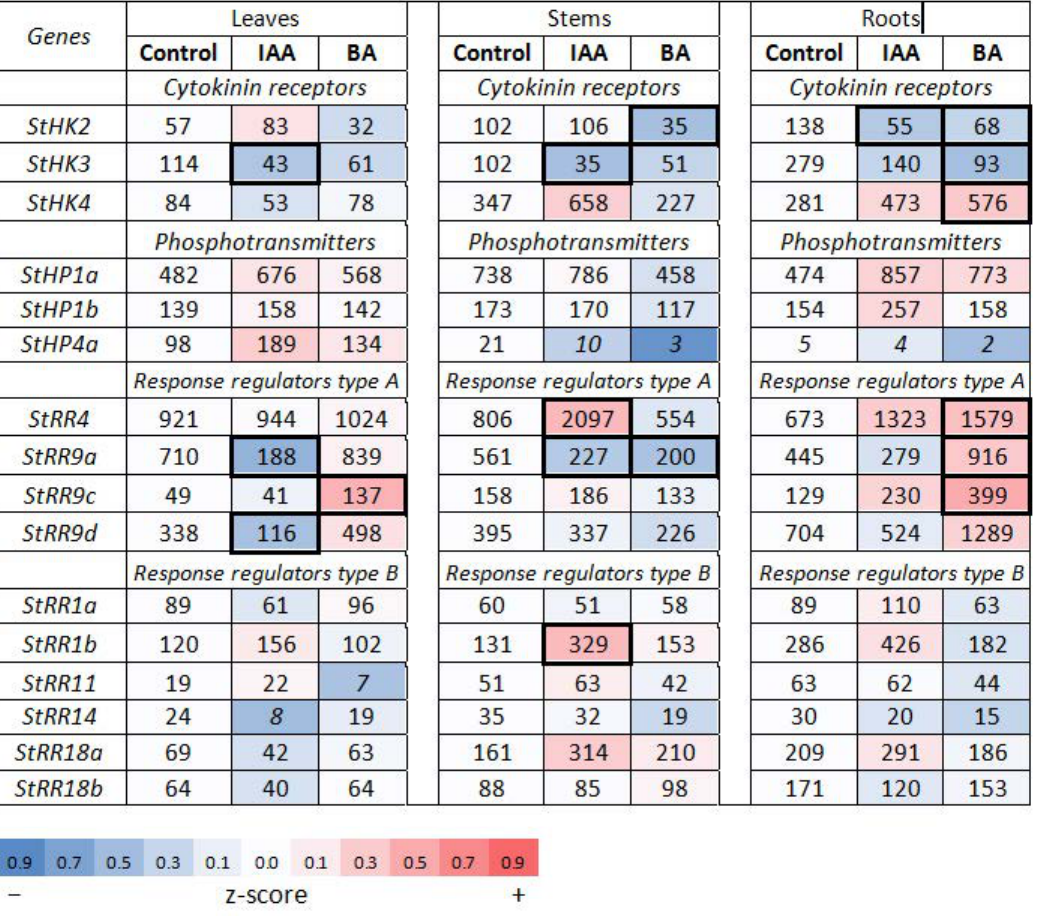
Figure 3. Effects of auxin (IAA) and cytokinin (BA) on the expression of the essential genes involved in cytokinin signaling in potato grown on medium with 1.5% sucrose. For heatmap details, see legend to Figure